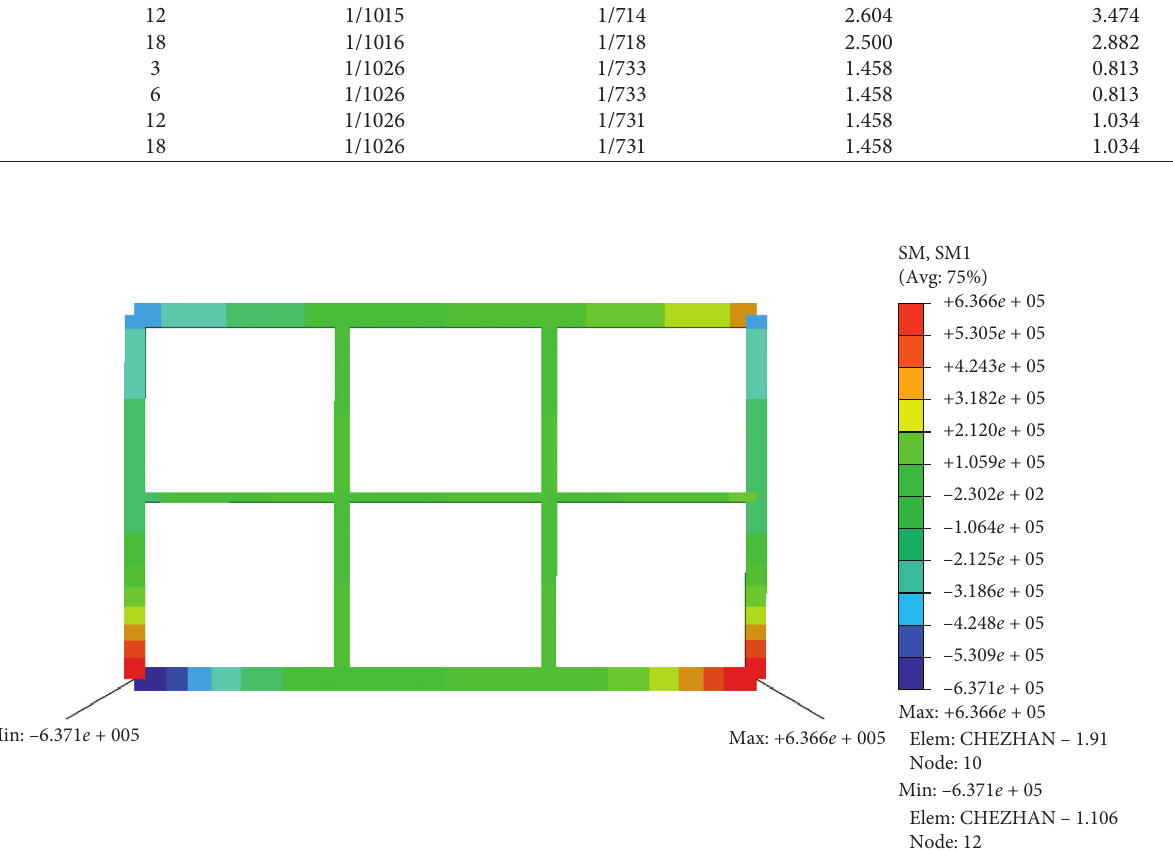
Figure 14: Bending moment cloud diagram of the station